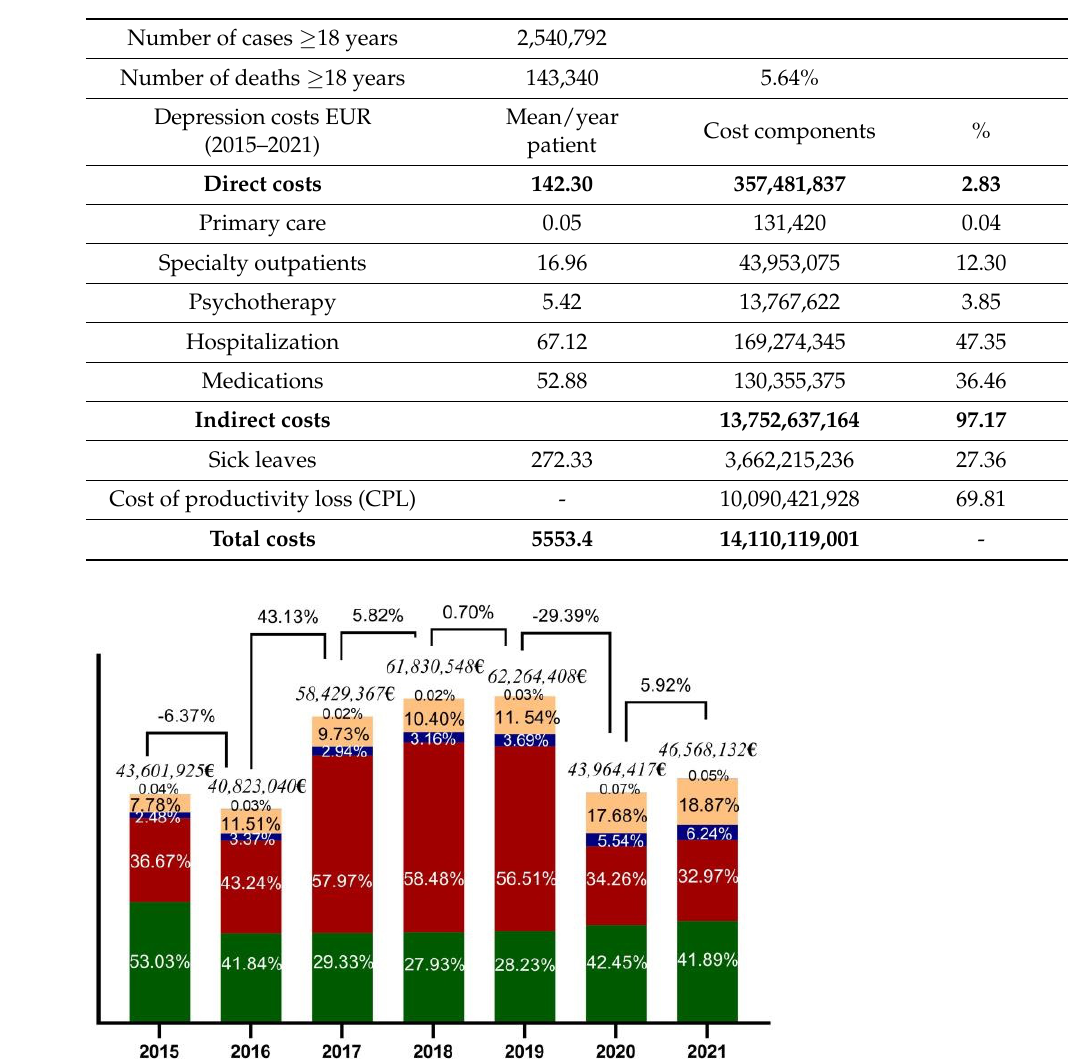
Table 1. Depression costs for patients in Romania between 2015 and 2021.